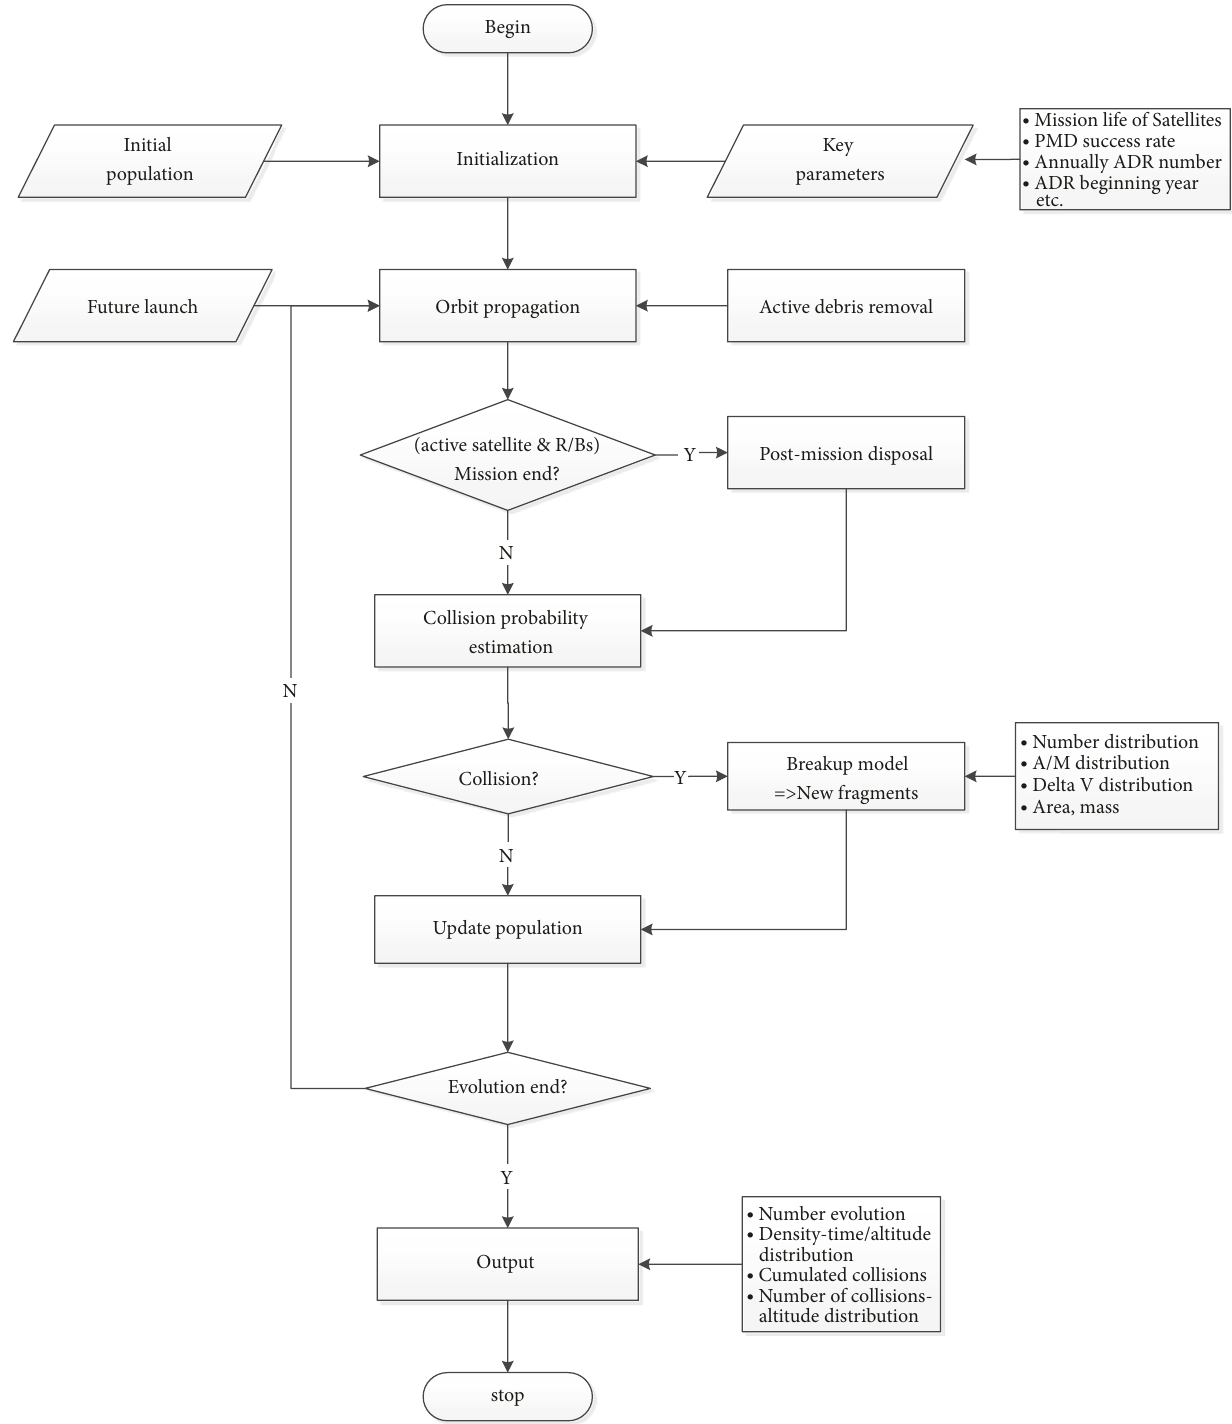
Figure 8: The workflow of SOLEM